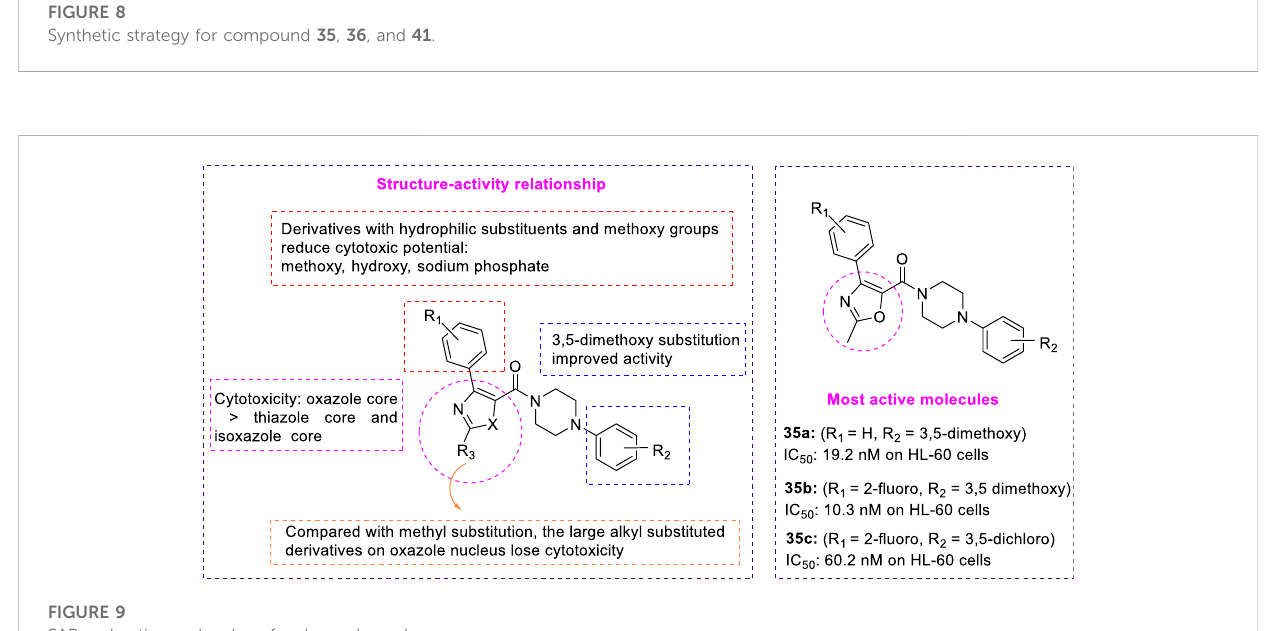
FIGURE 8 Synthetic strategy for compound 35 , 36 , and 41 .